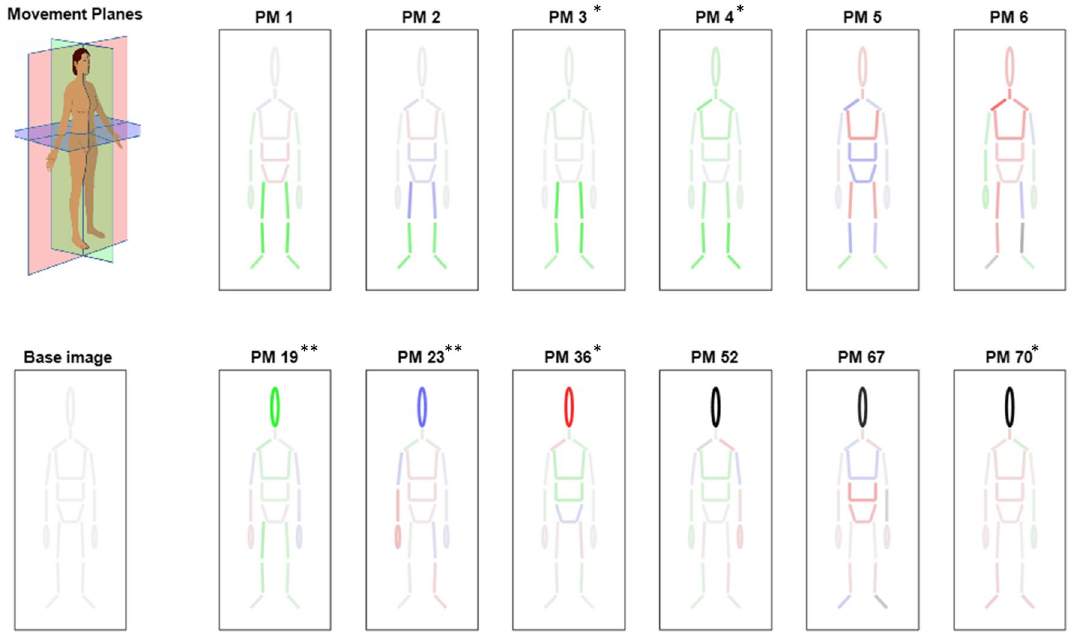
Figure 3. Visual representation of marker loading per body segment for the first 6 PMs and the 6 with the highest head marker loading. Movement Planes panel shows a colour index for the other panels: body segments depicted green are most active in the sagittal plane, segments depicted red are most active in the frontal plane and segments depicted in blue are most active in the horizontal plane. Movement Planes panel images is adapted from: https:// commo ns. wikim edia. org/ wiki/ File: Planes_ of_ Body_ unlab eled. jpg, under CC4.0, using paint.net. ‘Most active’ in this case means that the segment loading reached over 80% contribution on the two axes within specific plane. Base image panel shows the image in case all marker loadings would equal 0 to set a baseline for the PM panels. PM panels show marker loadings per body part, darker shades indicate greater marker loading for this segment. Asterisks indicate significant differences between conditions, where a single asterisk indicates significance in an uncorrected Friedman test and a double asterisk indicates significance in a Friedman corrected for 37 parallel comparisons. Of note here are the patterns associated with head movements which appear distributed across the